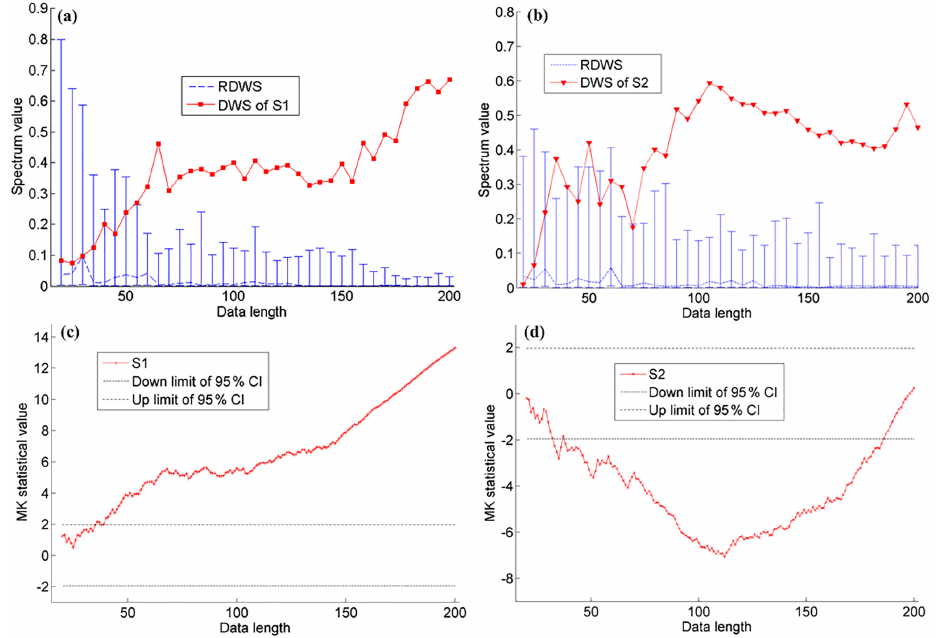
Figure 3. Evaluation of statistical significance of non-monotonic trends in the synthetic series S1 (a) and S2 (b) with different data length by the discrete wavelet spectrum (DWS) approach, and the results by the Mann–Kendall (MK) test (c, d) . In panels (a) and (b) , the dashed blue line is the reference discrete wavelet spectrum (RDWS) with 95% confidence interval under each data length; if the red data point at certain data length is above the blue bar, it is thought that the trend is significant at the 95% confidence level. In panels (c) and (d) , the two black dashed lines indicate the 95% confidence interval (CI) with the thresholds of ± 1.96 in the MK